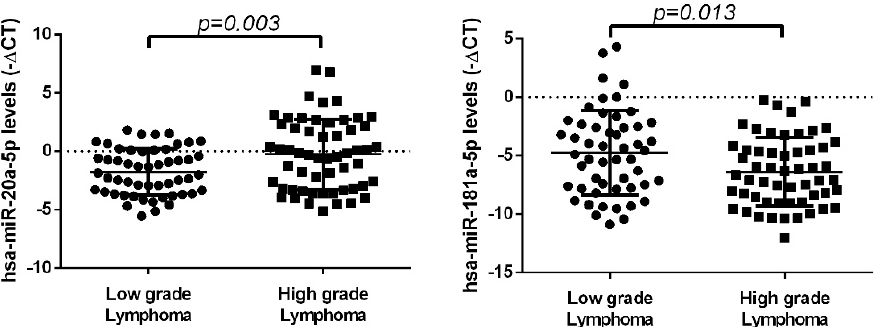
Figure 5. Expression levels of hsa-miR-20a-5p and hsa-miR-181a-5p in plasma samples of NHL patient groups according to lymphoma grade. Patients with high-grade lymphoma presented higher levels of hsa-miR-20a-5p and lower levels of hsa-miR-181a-5p compared to patients with low-grade lymphoma ( p = 0.003 and 0.013, respectively). The graphics represent the − ∆ CT of miRNA expression normalized to the endogenous control (mean ± SD).